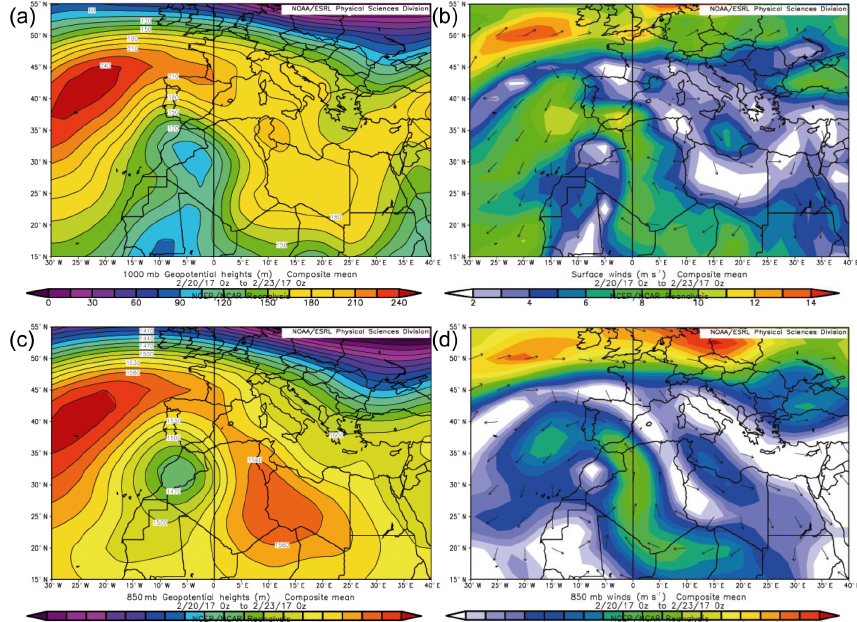
Figure 3. Synoptic-scale meteorological situation during the red rain event based on NOAA/ESRL reanalysis. Averaged geopotential high (a, c) and wind field (b, d) for 20–23 February 2017 at both ground level (1000hPa) and 850hPa ( ∼ 1500ma.s.l.) are